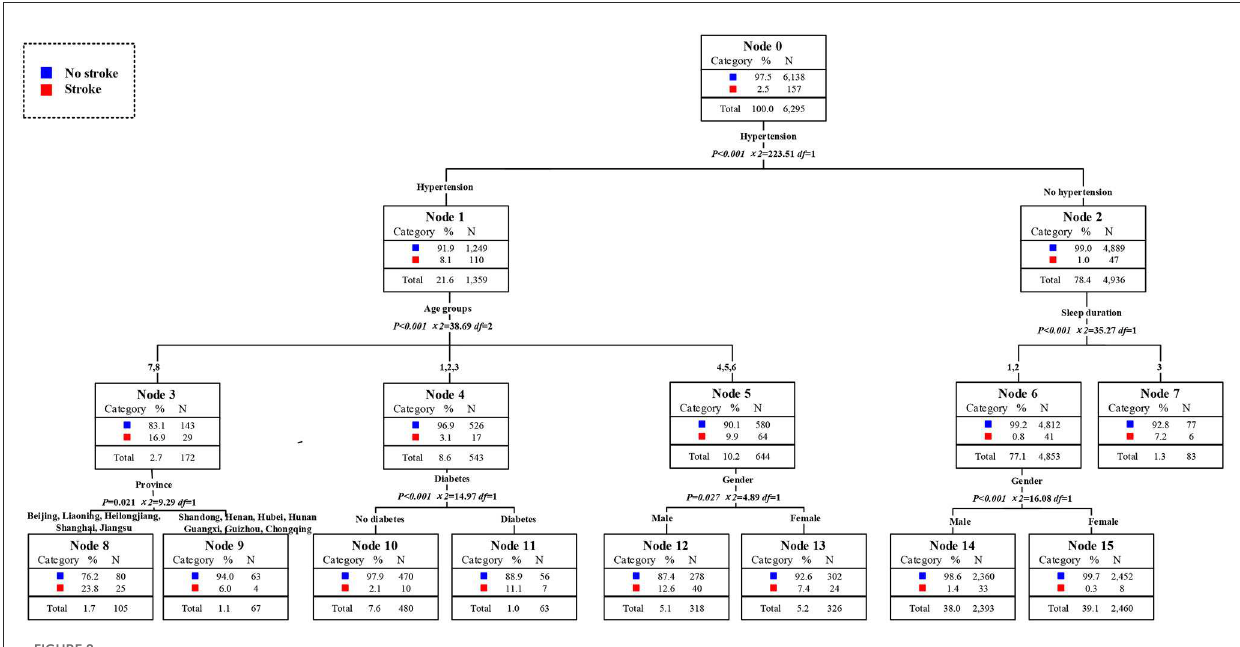
FIGURE8 Assessment of risk factors and the susceptible population of stroke in 2011.